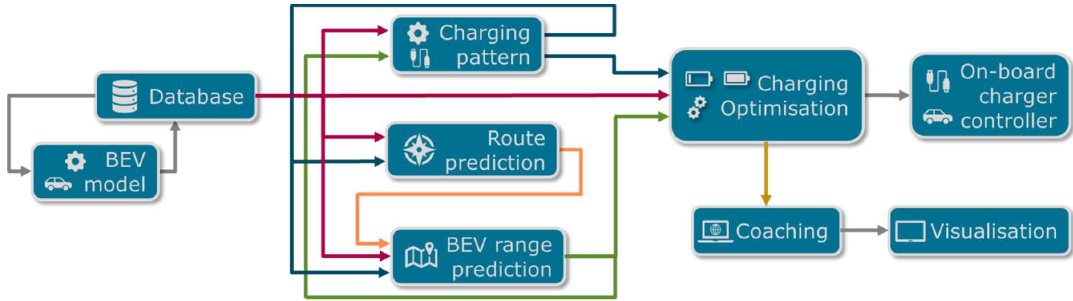
Figure 4. V2G algorithms.